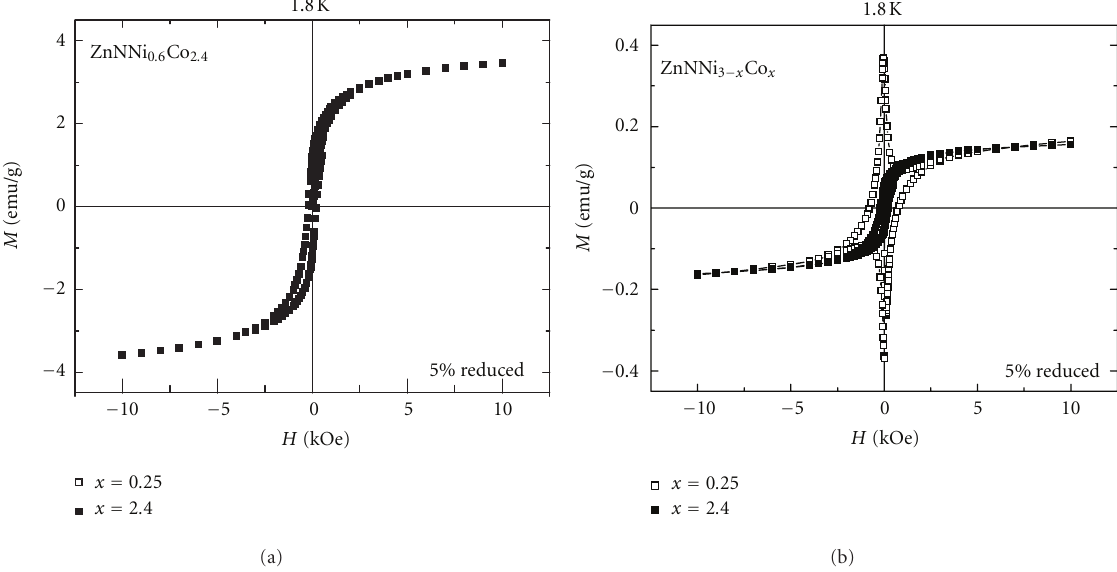
Figure 5: (a) Magnetic field dependence of magnetization at 1.8 K for ZnN y Ni 0 . 6 Co 2 . 4 . (b) Magnetic field dependence of magnetization at 1.8K for ZnN y Ni 0 . 6 Co 2 . 4 . The magnetization data is scaled by a factor of 0.05 and superimposed with the 1.8K data from Figure 3(a).